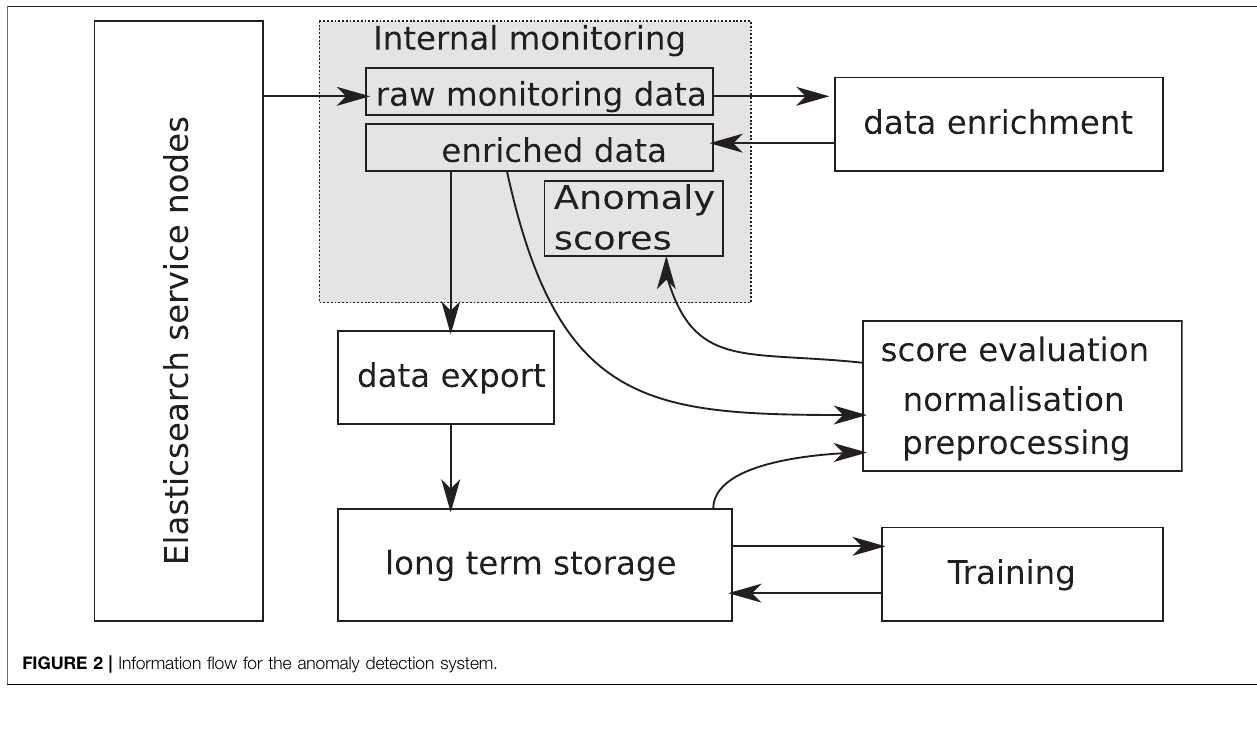
FIGURE 2 | Information fl ow for the anomaly detection system.